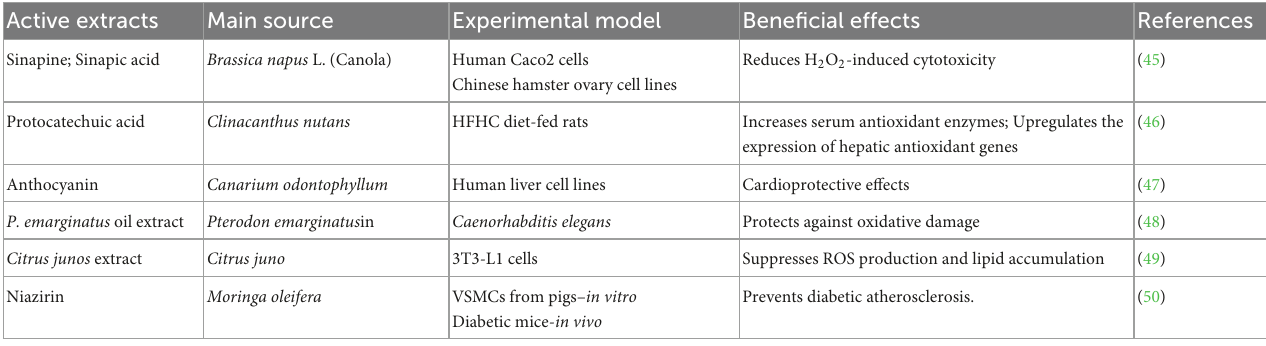
TABLE 2 Antioxidant effects of crude extracts of plant-based functional foods.